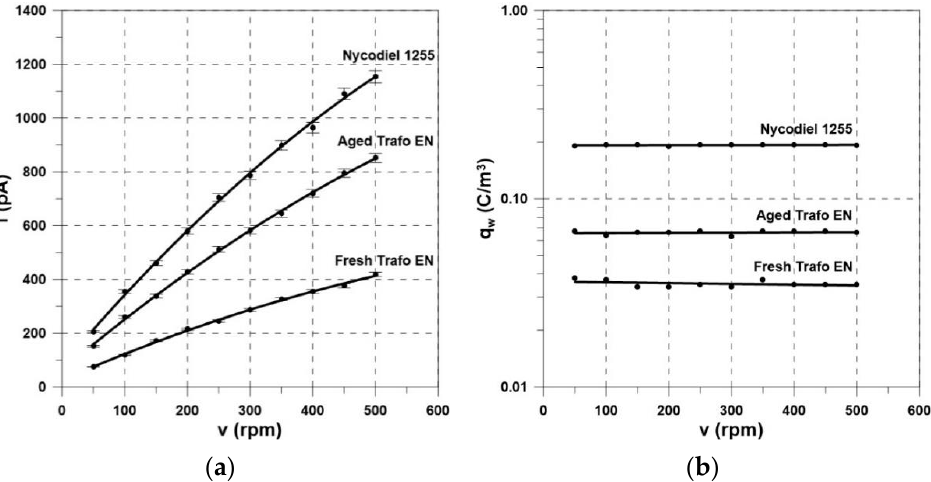
Figure 5. ( a ) Electrification current and ( b ) volume charge density q w of insulating liquids vs. rotational velocity of the disc ( d = 80 mm).